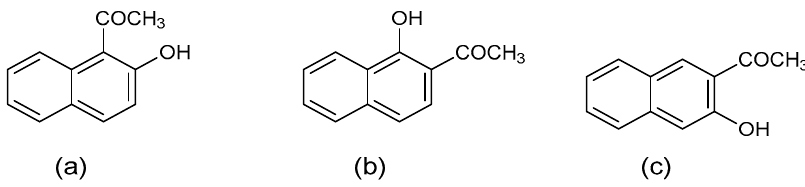
Figure 1. Structural formulae of 1-acetyl-2-naphthol ( a ), 2-acetyl-1-naphthol ( b ), and 2-acetyl-3-naphthol ( c ).